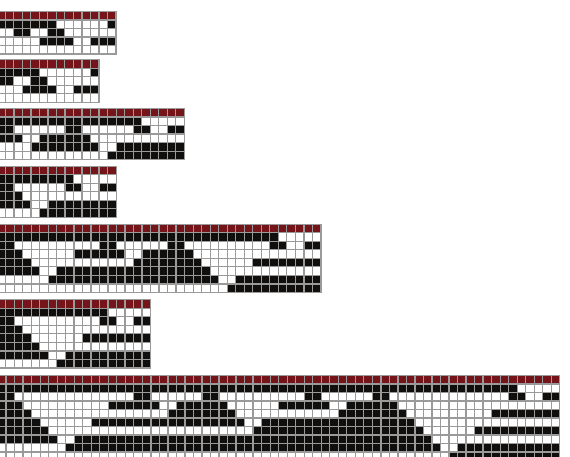
Figure 3: Alternating linear and exponential runtime behavior for TM 1728 529.